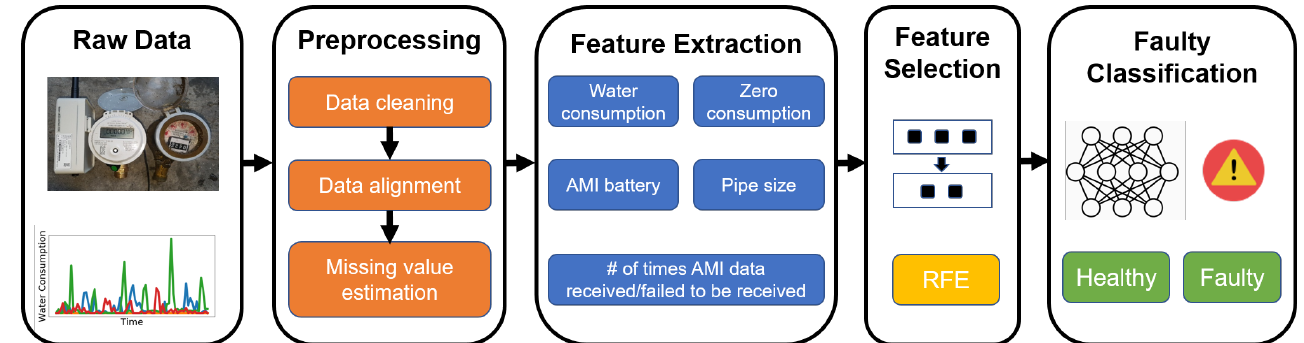
Figure 4. Proposed solution for predicting faulty RWMR